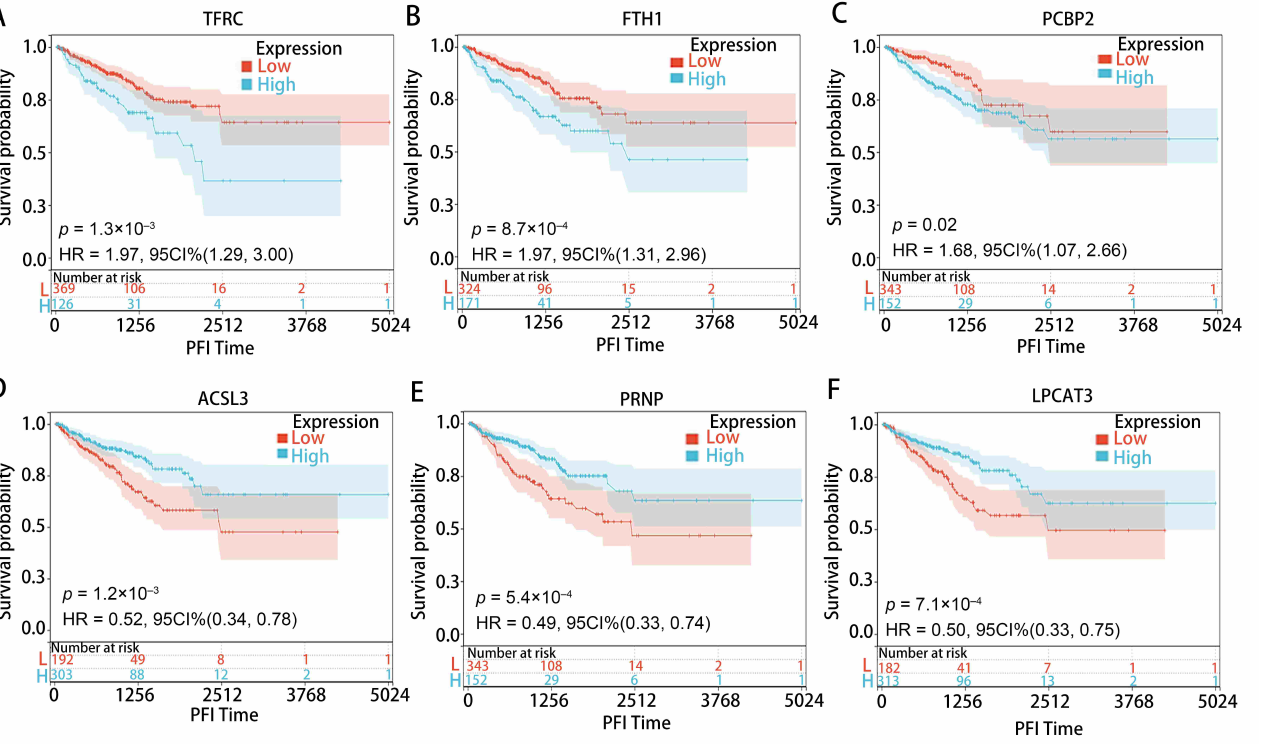
FIGURE 9. The prognostic value analyses of each signature in the PFI of PRAD. (A–F) The correlation between the expression of every signature, namely TFRC, FTH1, PCBP2, ACSL3, PRNP and LPCAT3, and PFI in patients with